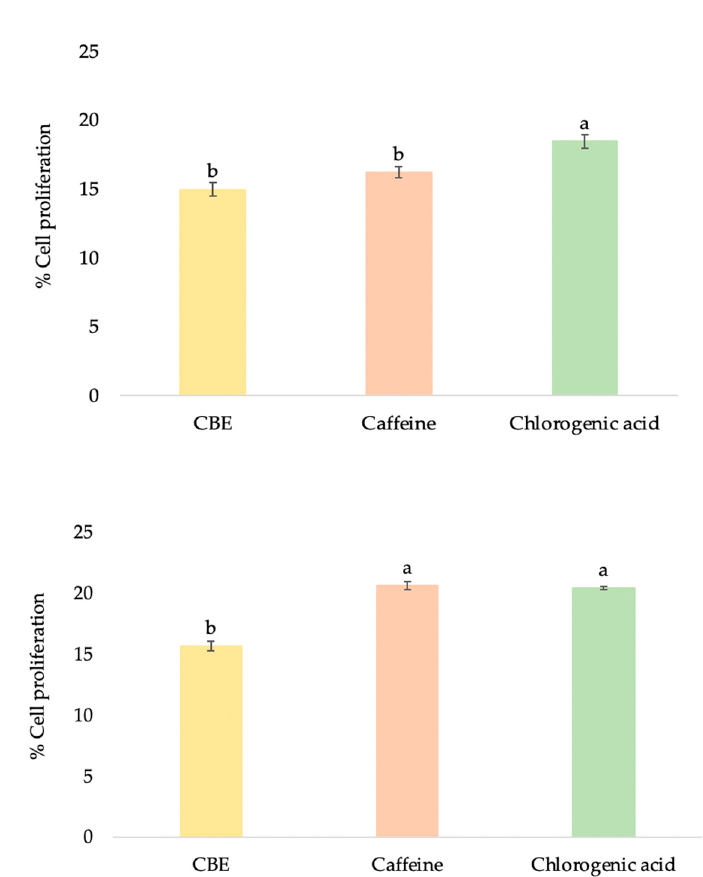
Figure 4. Effects of CBE, caffeine, and chlorogenic acid at maximum nontoxic concentrations on proliferation of HDF ( A ) and HFDP ( B ) cells. Data with different lower-case letters (a and b) indicate significant differences ( p < 0.05) between samples.